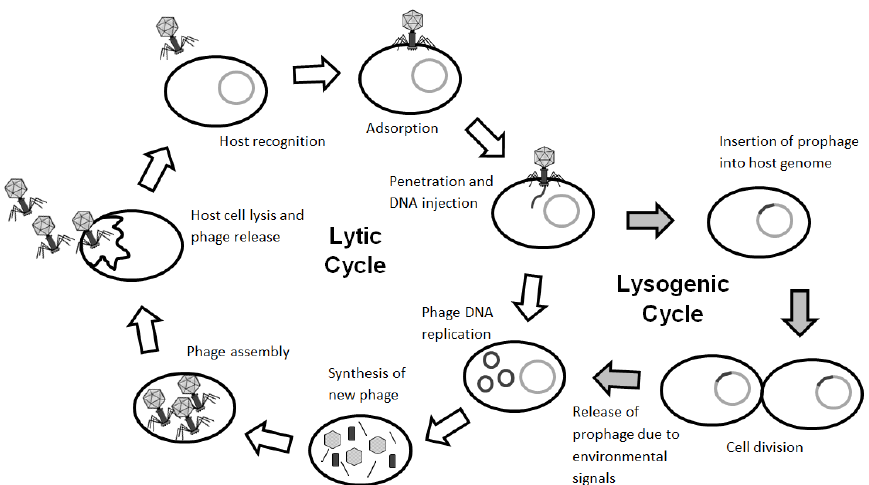
Figure 2. The phage life cycle. Lytic phage go through the lytic cycle, in which the host is lysed and progeny phage are released into the environment. Temperate phage can go through the lytic or the lysogenic cycle. Some phage rely on small molecules to communicate and execute lysis–lysogeny decisions [8]. In the lysogenic cycle, the phage genome is incorporated into the host genome; this phage DNA—now called a prophage—can be induced, leading to the expression of phage DNA and the lytic cycle.